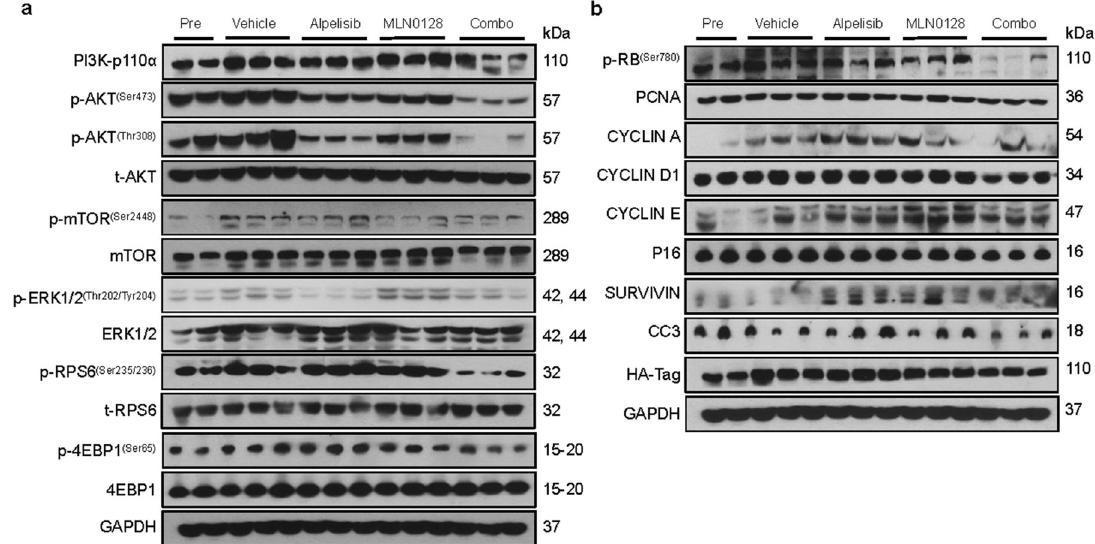
Fig. 6 Effects of alpelisib/MLN0128 treatment on the levels of putative target proteins in livers from c-Met/H1047R mice. a Western blot analysis of AKT/mTOR and Ras/MAPK pathways in pretreated, treated with vehicle, alpelisib, MLN0128, and alpelisib/MLN0128 c-Met/H1047R mice. b Western blot analysis of proliferation signaling pathways in pretreated, treated with vehicle, alpelisib, MLN0128, and alpelisib/ MLN0128 c-Met/H1047R mice. Pre Pretreatment, Combo combined alpelisib/MLN0128 treatment, CC3 CLEAVED